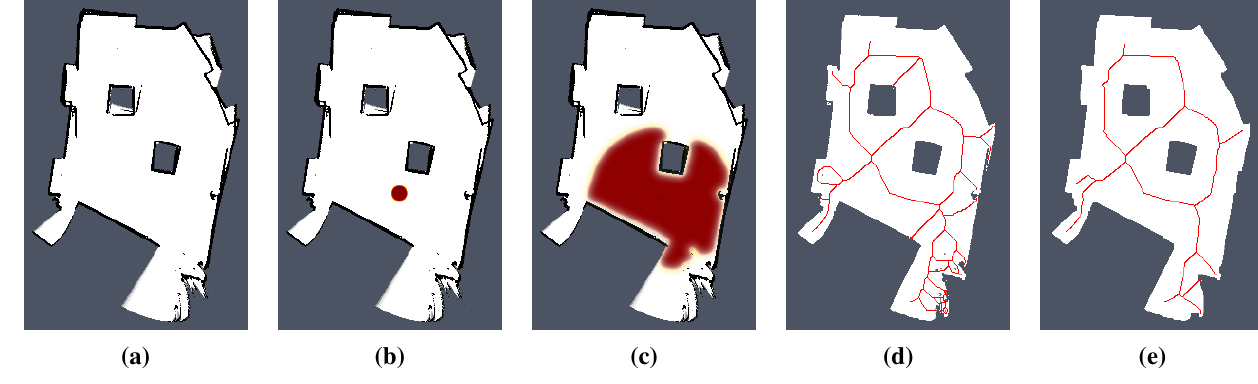
Figure 3. A visualization of sensor measurements transferred to the integration grid of the FHN model for the environment called cube and examples of conventional Voronoi diagrams: ( a ) occupancy grid with integrated sensor measurements where detected obstacles are in black, identified freespace is in white, and unknown parts of the environment are in gray; ( b , c ) the occupancy grid that represents the map of the environment is transferred (merged) to the integration grid of the model, where a wavefront is triggered; ( d ) conventional Voronoi diagram in the rough map; ( e ) conventional Voronoi diagram in the map after removing noisy measurements by application of dilation and erosion operations of the mathematical morphology.